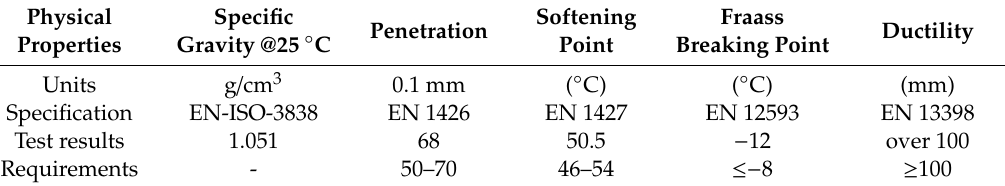
Table 1. Conventional properties of the neat bitumen.